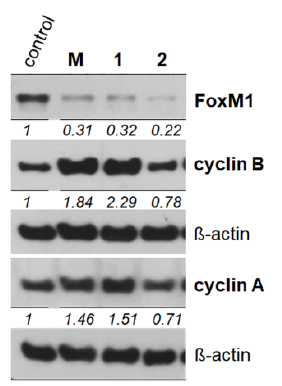
Figure 3. Cell cycle-related proteins. Protein lysates of SW480 cells were harvested after 48 h of exposure to 15 µM M , 1 and 2 , and the protein levels of FoxM1, cyclin B and cyclin A were analyzed by western blotting. The numbers below the bands give the mean fold increase of three independent experiments ( n = 3, control set to ß-actin).